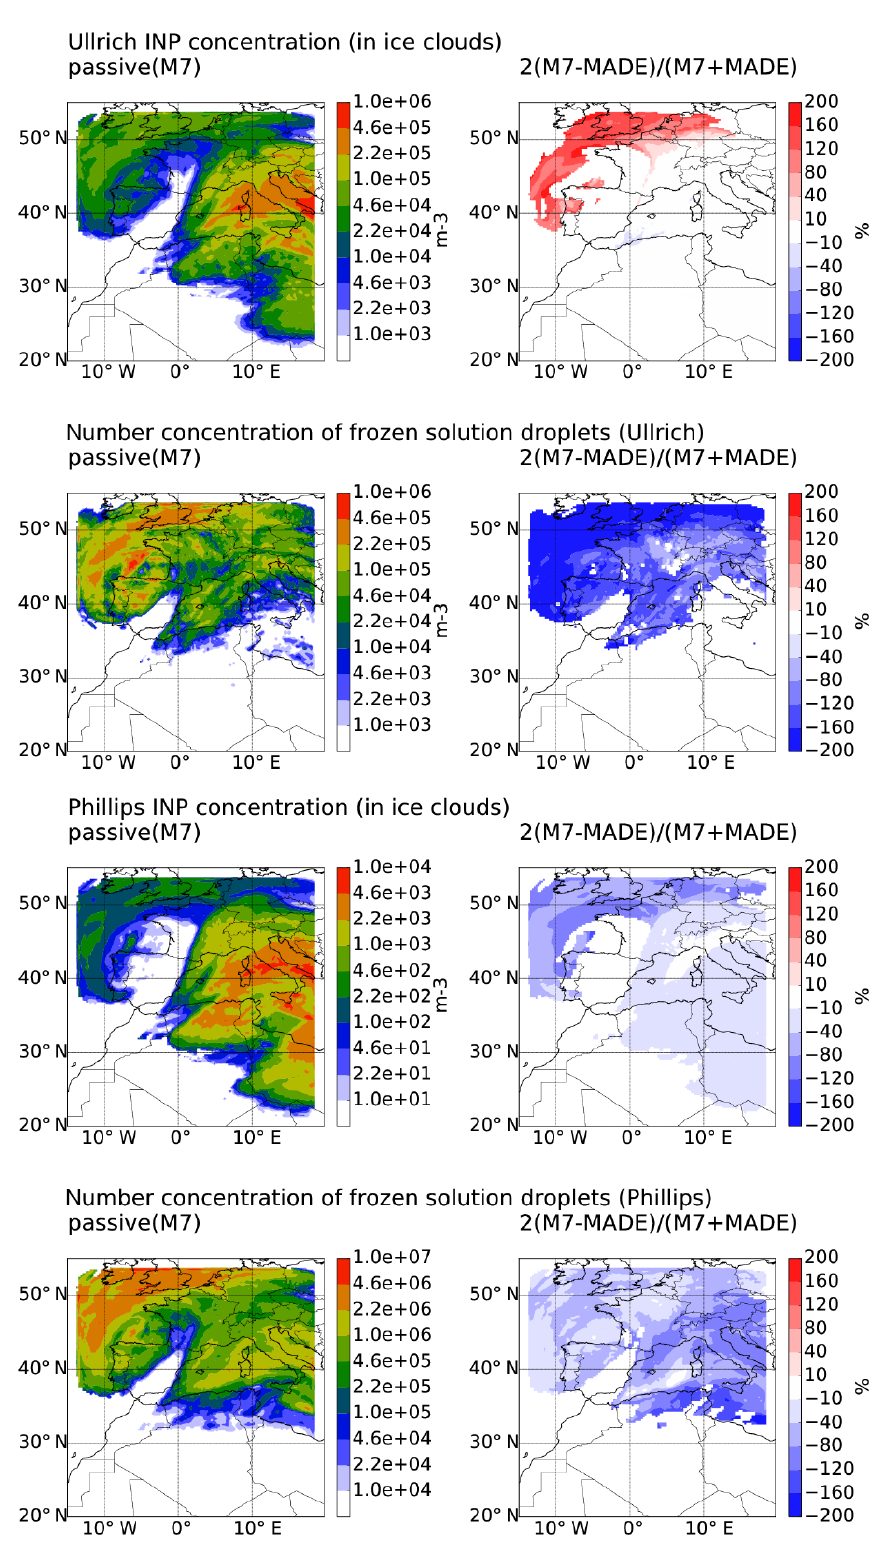
Figure 13. INP and frozen solution droplet concentrations in ice clouds derived from aerosol compositions predicted by M7 (left column) and MADE (relative-difference plots in the right column) using the Ullrich (first and second row) and the Phillips (third and last row) ice- nucleation parameterizations. Contours show vertical averages of concentrations in grid boxes that contain ice- but no liquid-phase cloud water. See Fig. 3 for plot